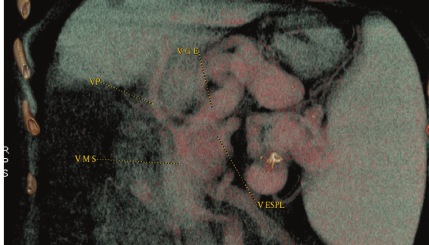
Figure 5: Postoperative angiotomography demonstrating a pervi- ous gastroportal